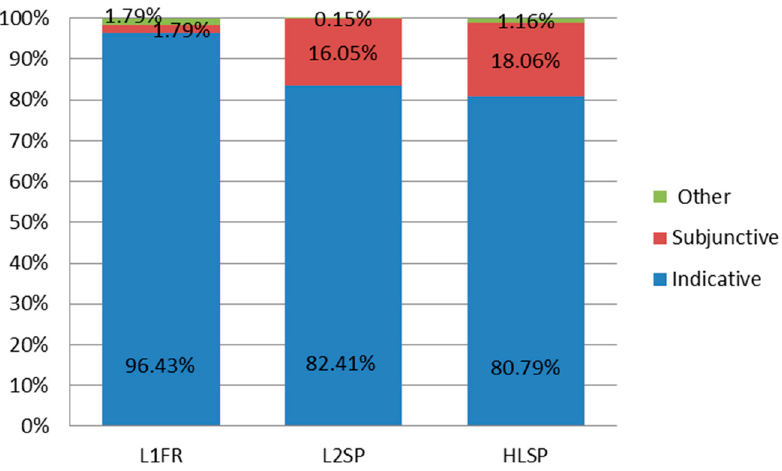
Figure 5. Sentence completion task in French (Task 2)—Overall results.